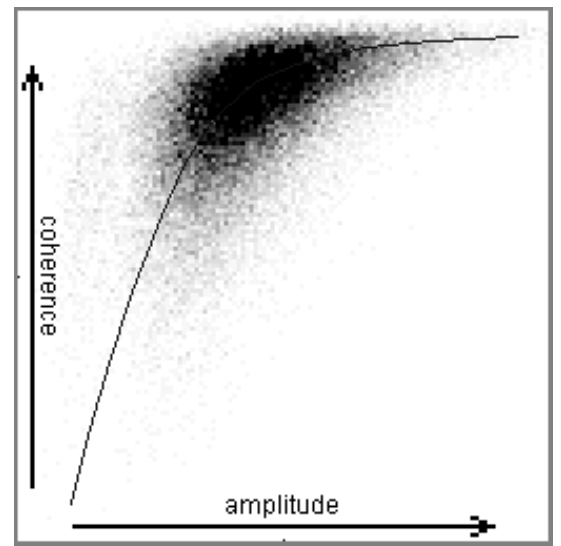
Figure 1. The relationship between the coherence and amplitude. It is a 2-D histogram of the coherence and amplitude in a forest area (10,000